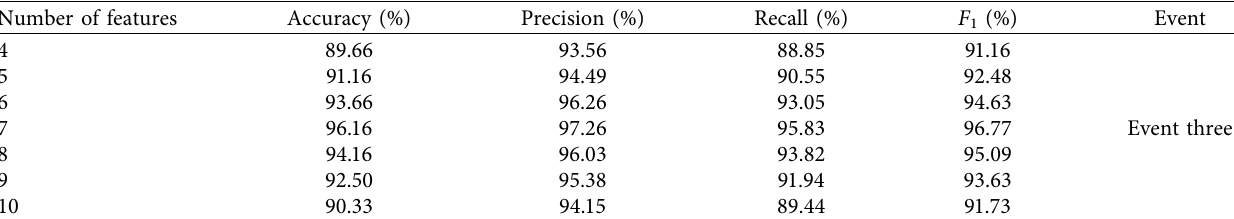
Table 9: Model performance with different indicators in event